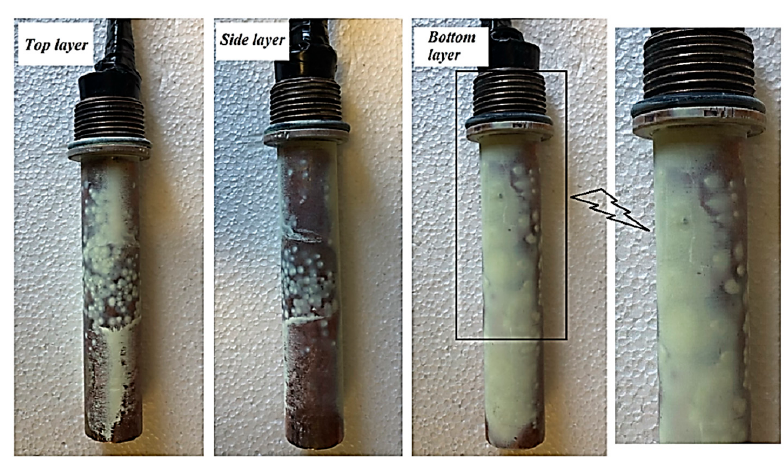
Figure 12. Schema of tungsten oxide WO 3 nanoflakes deposition on the heating surface.